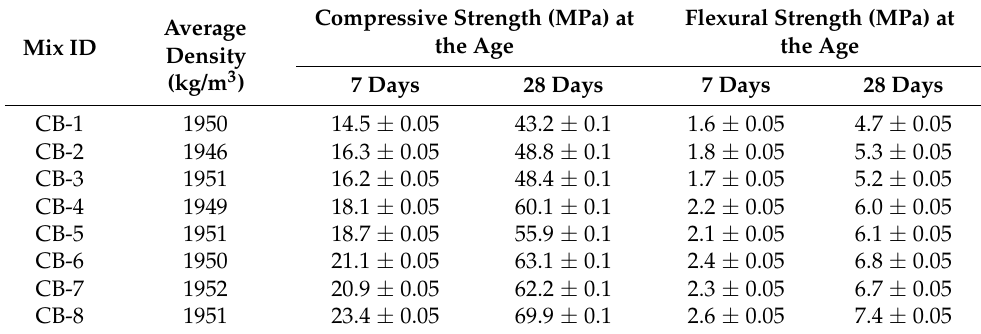
Table 8. Physical and mechanical properties of the CB.